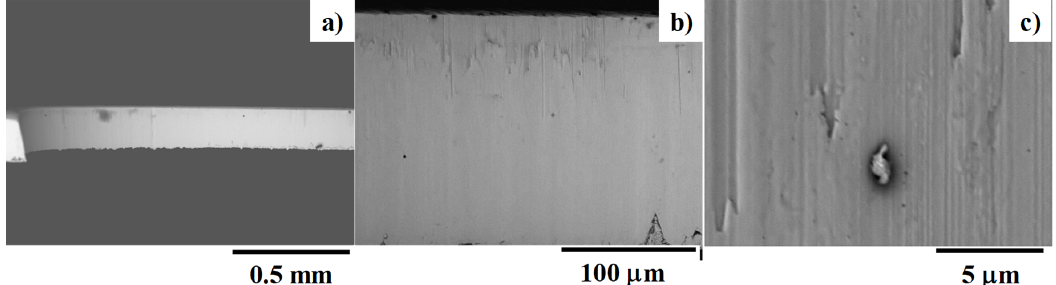
Figure 8. SEM images of the pierced hole surfaces with different magnifications. ( a ) Overall image of the hole pierced into the AISI316L sheet, ( b ) the burnished surface of the hole, and ( c ) the nanotextures transcribed onto the hole’s surface.